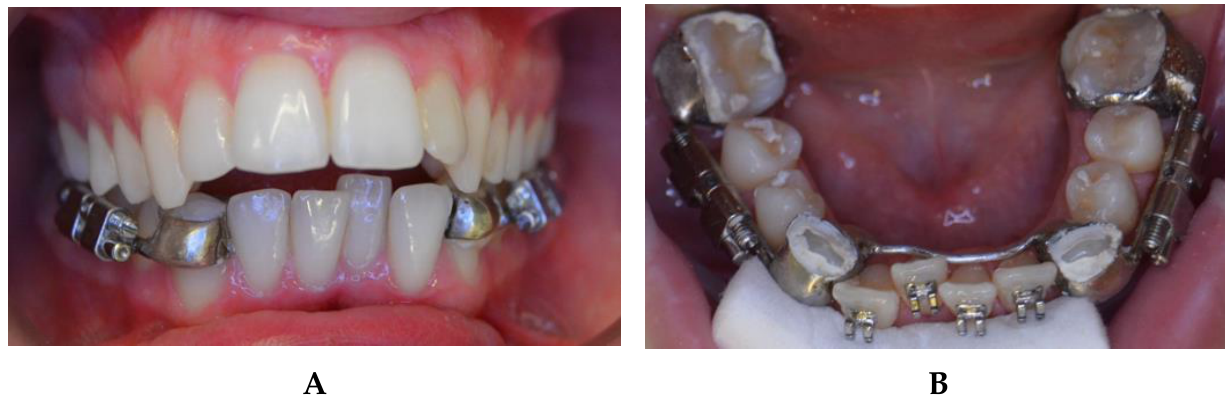
Figure 3. Intra-oral photographs: ( A ) frontal photograph before placement of the fixed multibracket appliance and surgery; ( B ) cementation of the distractor before surgery with Ketac™ Cem (3M-ESPE, Seefeld, Germany).